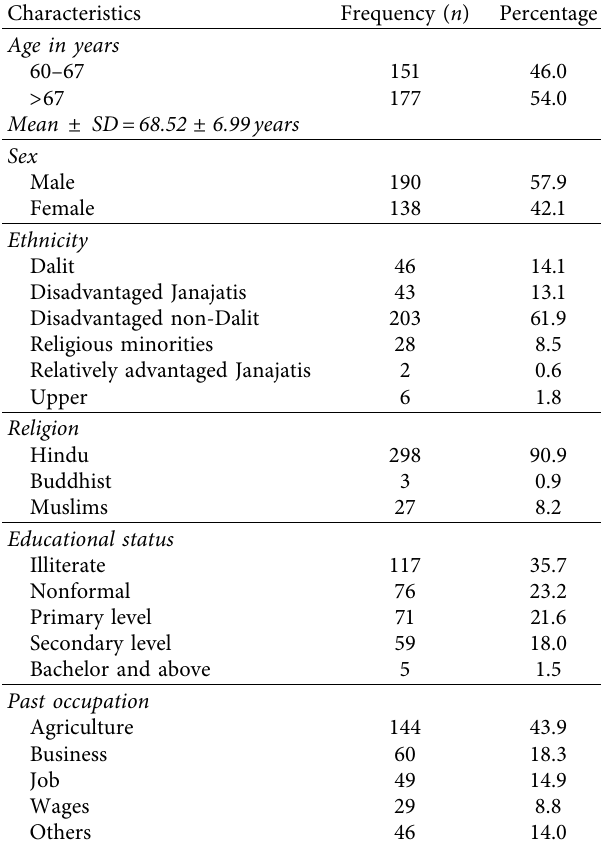
Table 1: Distribution of sociodemographic information of par- ticipants ( n �